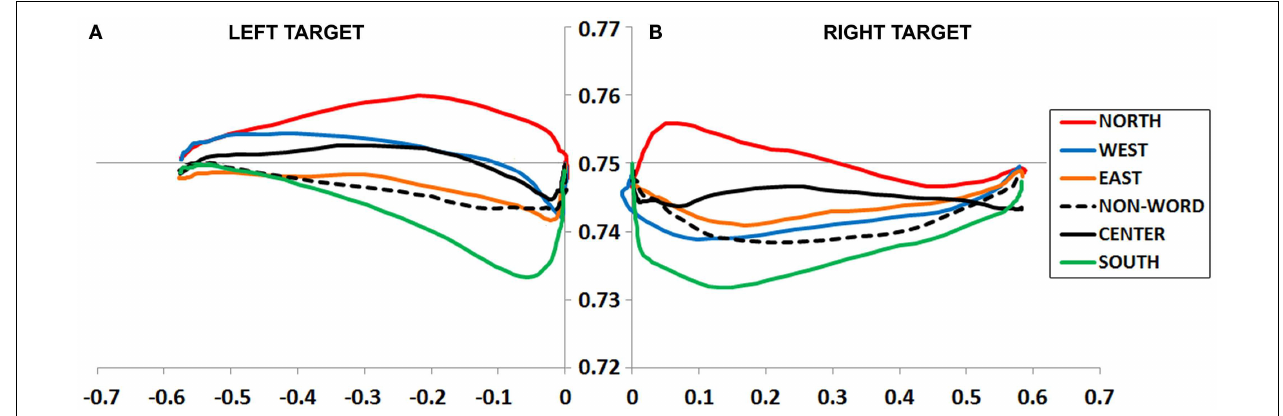
FIGURE 3 | (A,B) Experiment 1 plotted movement trajectory data for the Left (A) and Right (B) target locations, for each of the six